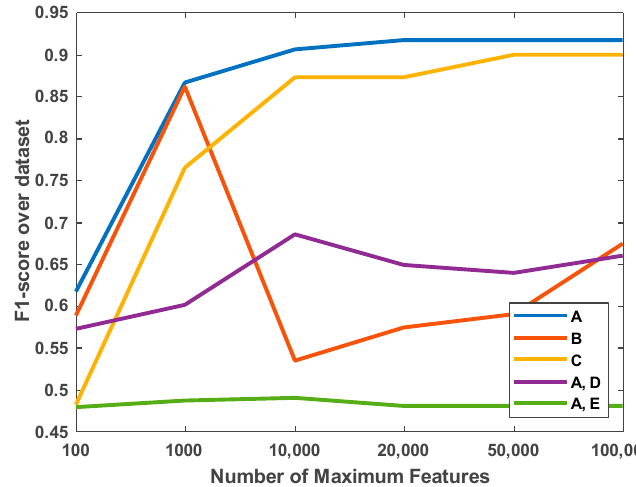
Figure 4. TF-IDF Experiments.